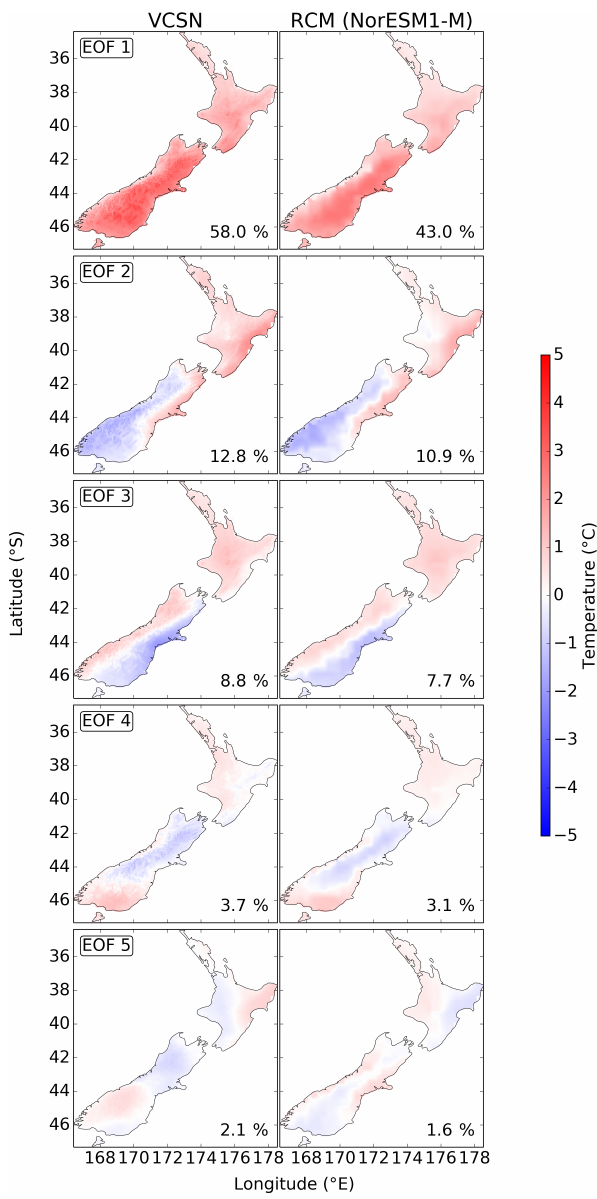
Figure 6. The first five EOF patterns of weather noise in daily max- imum surface temperatures obtained from VCSN data from 1972 to 2013 (left column) and obtained from RCP8.5 NorESM1-M RCM output from 1972 to 2100. The colour bar shows the amplitude of the pattern in ◦ C. The percentage values in each panel show the fraction of the total variability explained by each